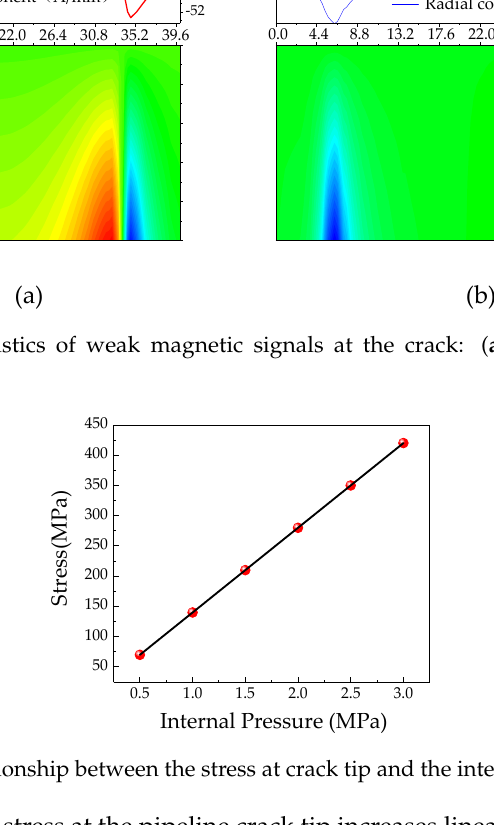
Figure 4. The characteristics of weak magnetic signals at the crack: ( a ) axial component and ( b ) radial component.